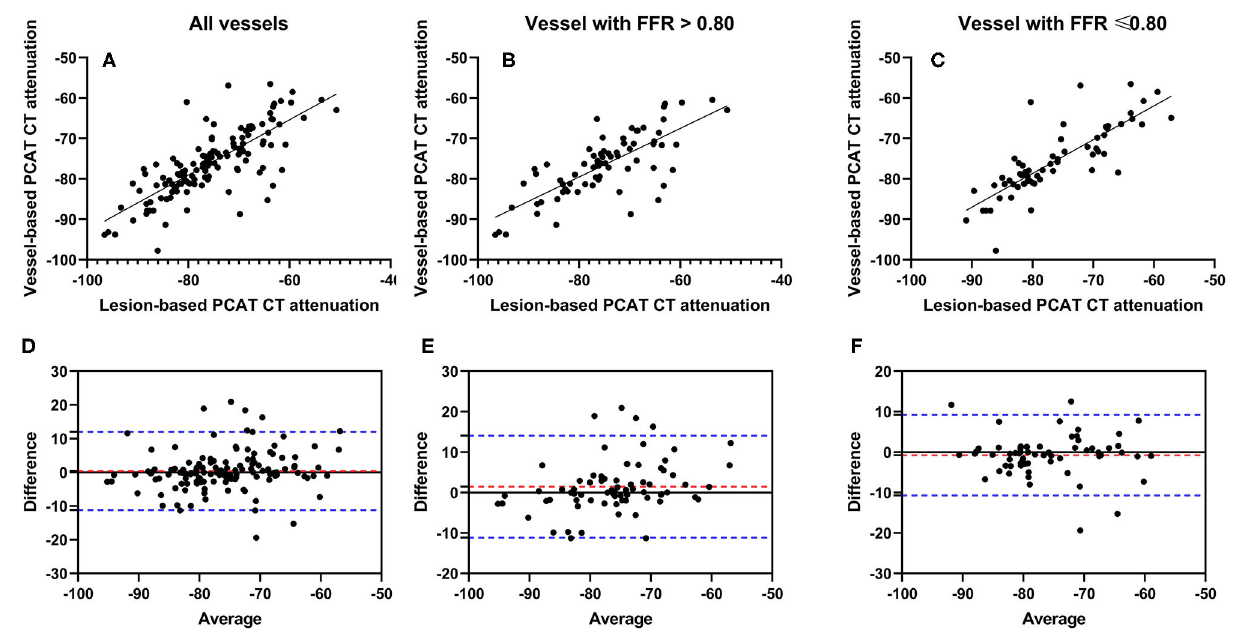
FIGURE 2 | Correlation and Bland-Altman plots of vessel-based and lesion-based PCAT CT attenuation as clarified by invasive FFR. Pearson correlation analyses show the correlation vessel-based and lesion-based PCAT CT attenuation in all vessels (A) , vessels with FFR > 0.80 (B) and vessels with FFR ≤ 0.80 (C) , respectively. Bland-Altman plots show PCAT CT attenuation between vessel-based and lesion-based in all vessels (D) , vessels with FFR > 0.80 (E) and vessels with FFR ≤ 0.80 (F) . The red dotted lines represent the mean difference (bias), and the blue dotted lines represent the 95% limits of agreement. FFR, fractional flow reserve; PCAT, pericoronary adipose